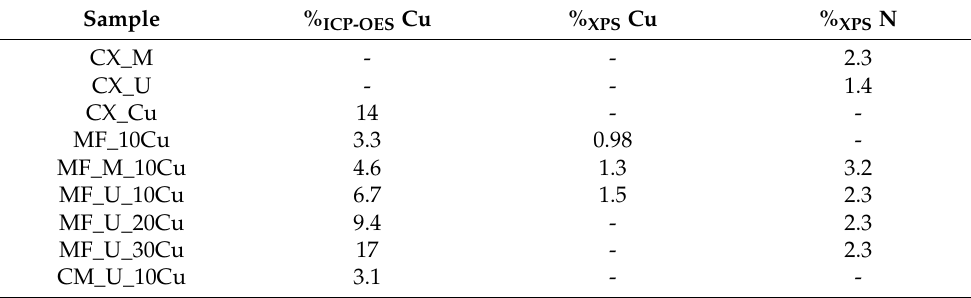
Table 2. Copper and nitrogen content determined by ICP-OES and XPS.